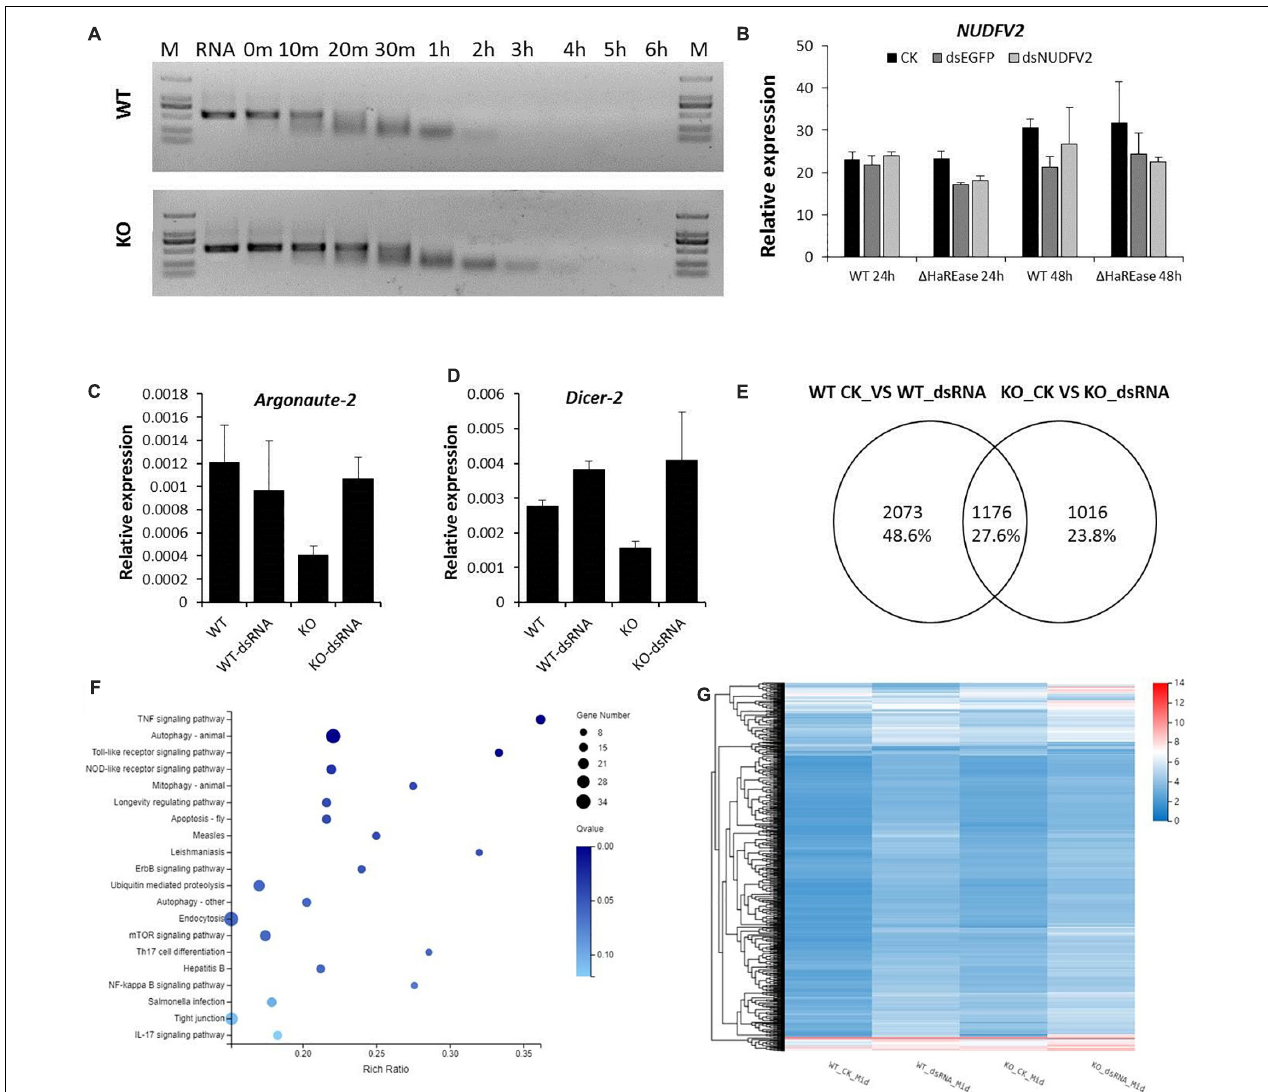
FIGURE 5 | Effects of HaREase on the dsRNA degradation rate and RNAi pathway. (A) Degradation of dsRNA in midgut extractions form KO and WT. Diluted KO and WT midgut extraction solutions were incubated with 50 ng/ µ l dsEGFP. The dsRNA degradation rate was detection by agarose gel electrophoresis. (B) RNAi efficiency of 10 µ g dsNUDFV2 injected into the third instar of WT and KO larvae. The expression levels of NUDFV2 were detected by RT-qPCR 6 h after treatment. (C,D) Expression levels of argonaute-2 and dicer-2 after dsEGFP treatment in the third instar of WT and KO larvae. (E) Veen diagram of dsEGFP-induced differentially expressed genes in WT and KO. (F) KEGG pathway analysis of the differentially expressed genes. (G) Heat map showing differences in gene expression between WT and KO. The color scale indicates the different expression